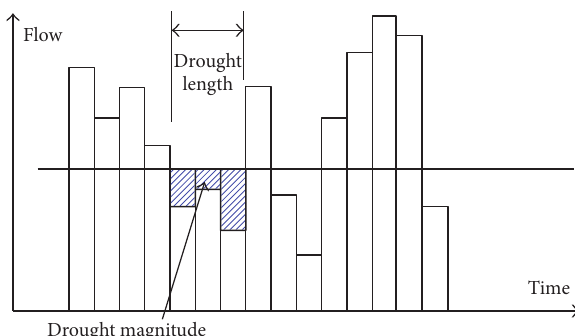
Figure 2: Definition of drought